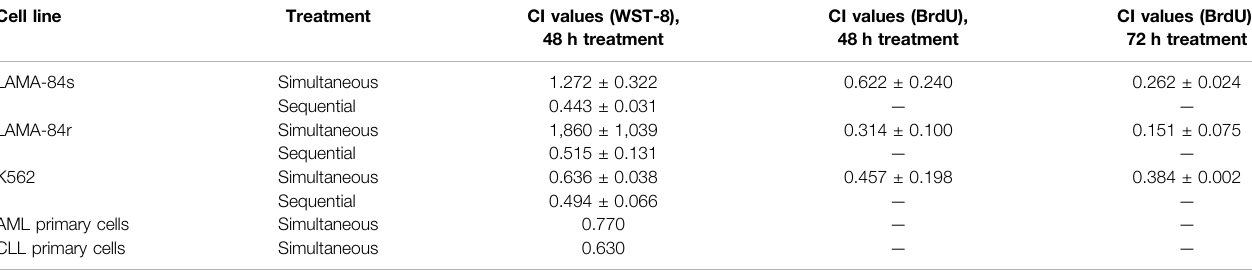
TABLE 2 | Combination index (CI) values on leukemia cell lines as determined by WST-8 and BrdU incorporation assays. Cell line